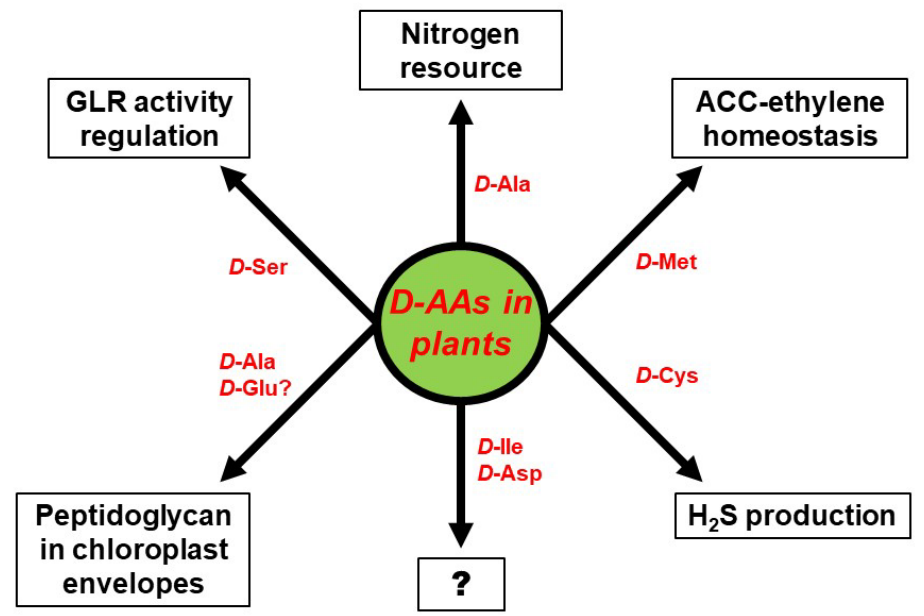
Figure 3. Proven and putative physiological functions of particular d -AAs in plants. The question mark (?) stands for yet unknown functions.